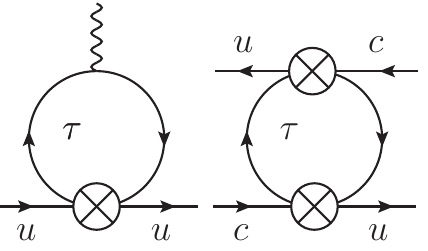
Figure 2: Diagrammatic representation of the u -quark EDM (left) and the contribu- tion to D –¯ D mixing (right) originating from single and double insertions of the tensor operators, respectively.